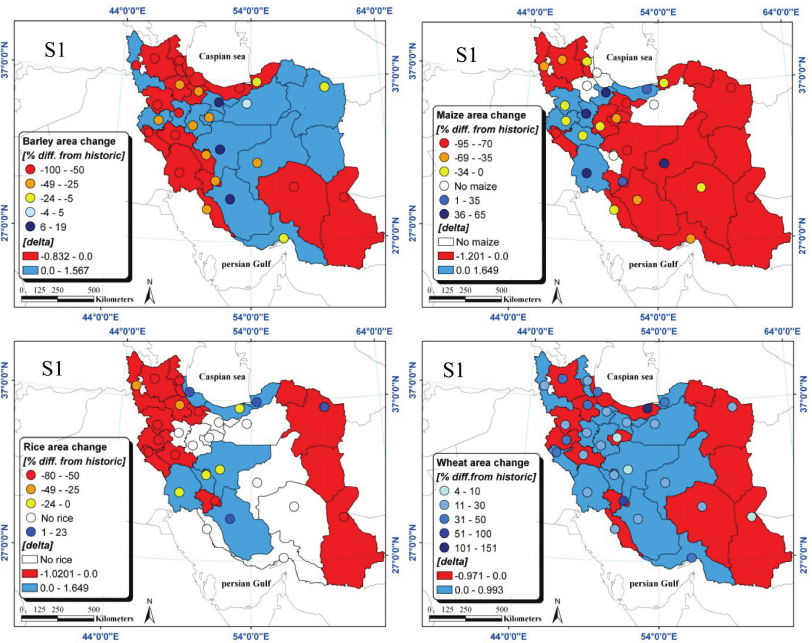
Fig. 5. Adjusted structure of cropping pattern in S1 to S5. Circles show % differences from the long-term (1990–2004) average area in Fig. 4. The background colors show the provinces delta index where blue indicates positive performance and red indicates negative performance with respect to national